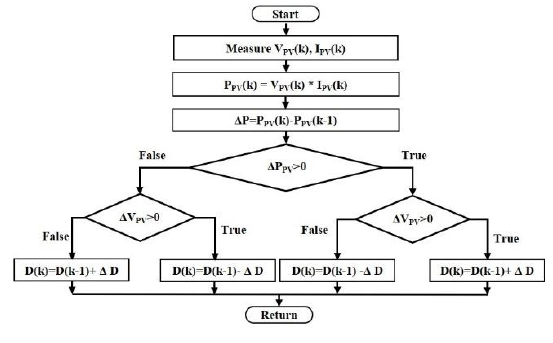
Fig. 7: Perturb and Observe